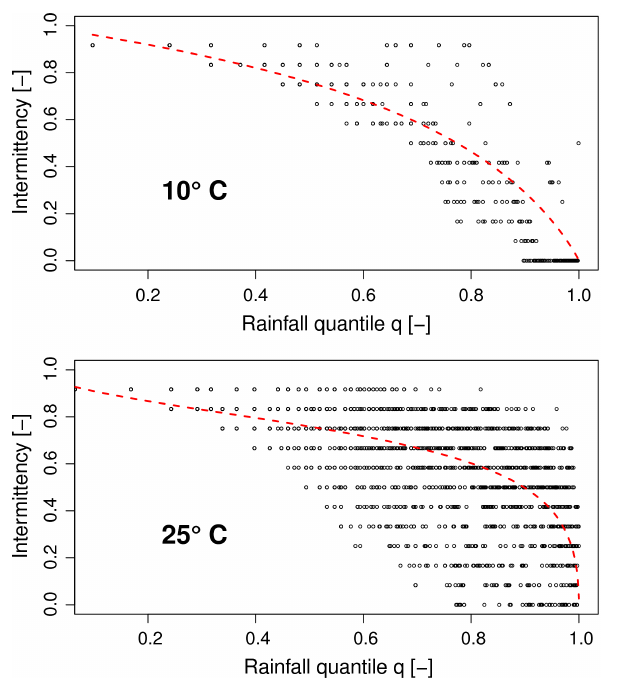
Figure 3. Logistic regression between intermittency and rainfall quantile at AL-Fairhope-3-NE for the 1h timescale and two dif- ferent temperatures (10 and 25 ◦